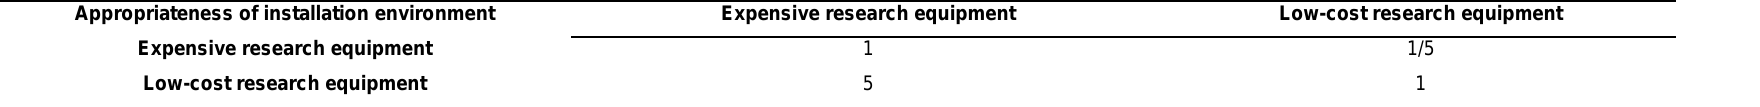
Table 10. Importance evaluation of appropriateness of installation environment